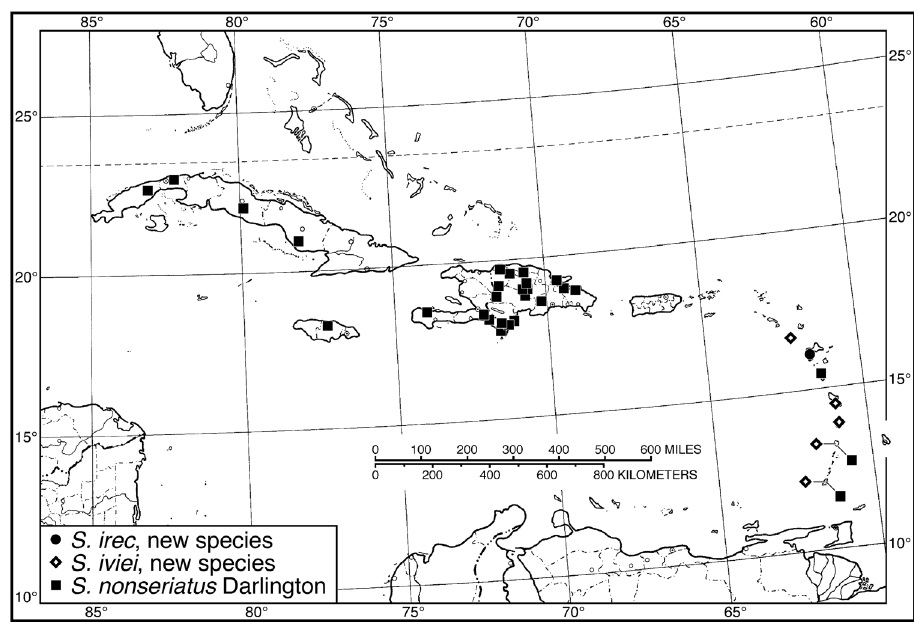
Figure 38. Map of West Indies showing known localities for species of Selenophorus nonseriatus species